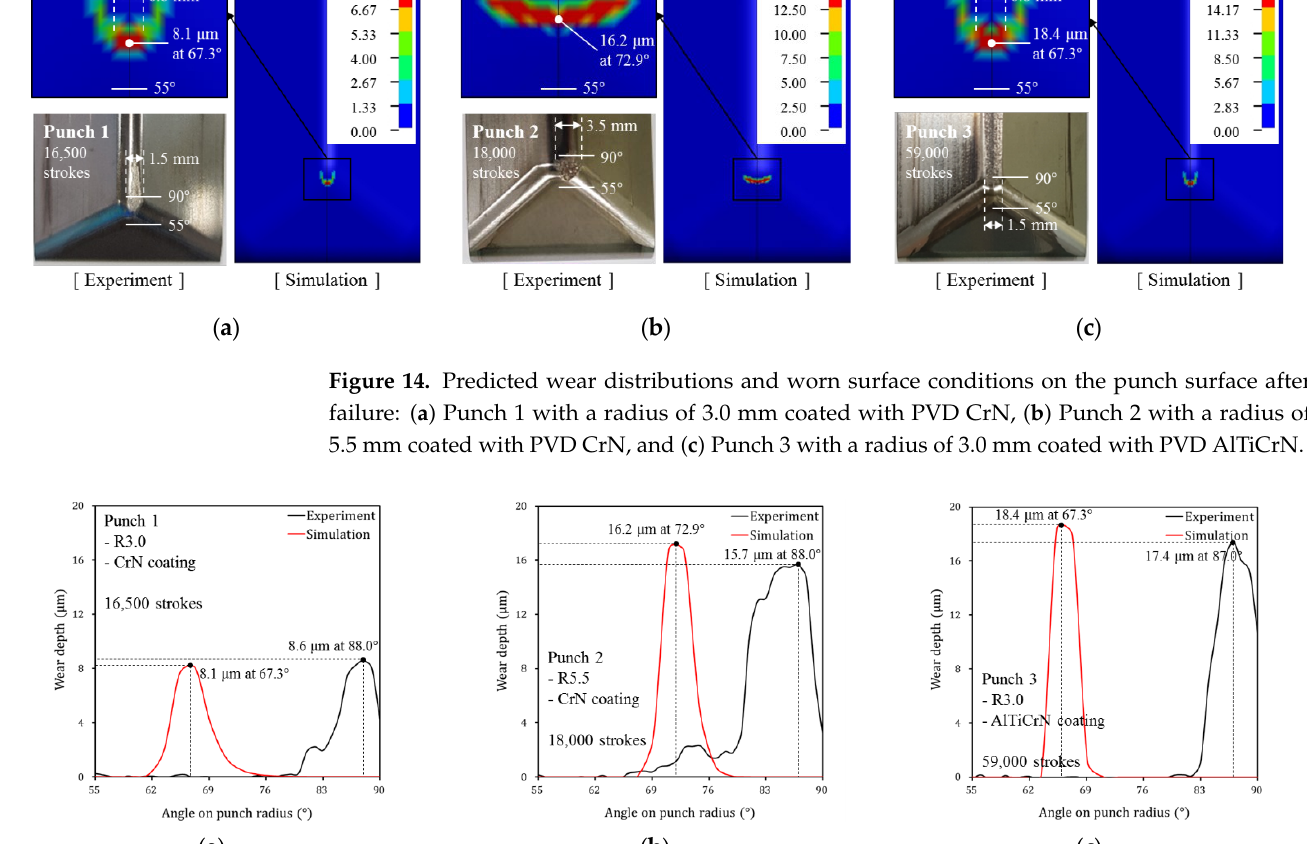
Figure 15. Wear depth on the punch radius obtained from experiments and simulations after the failure: ( a ) Punch 1 with a radius of 3.0 mm coated with PVD CrN, ( b ) Punch 2 with a radius of 5.5 mm coated with PVD CrN, and ( c ) Punch 3 with a radius of 3.0 mm coated with PVD AlTiCrN.